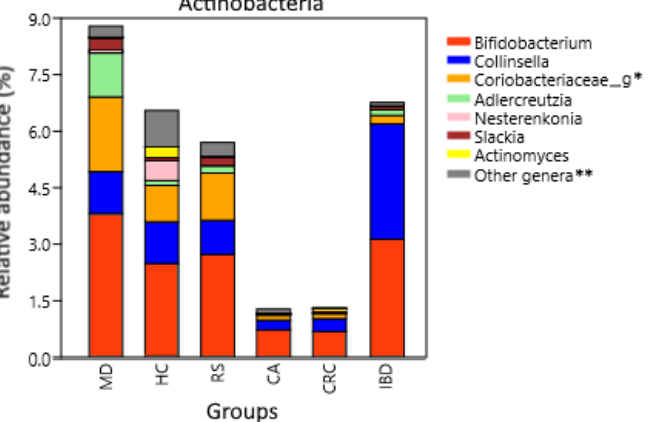
Figure 4. Actinobacteria composition at the genus level. Relative abundance corresponds to the average percentual fraction of reads in the group representing each OTU. Groups: Subjects following a Mediterranean diet (MD), healthy subjects (HC), subjects at risk of developing colorectal cancer (RS). Patients with colon adenoma (CA), colorectal cancer (CRC), or inflammatory bowel diseases (IBD). * Genus or genera unannotated in the reference database. ** Less abundant genera and sequences that could not be classified at the genus